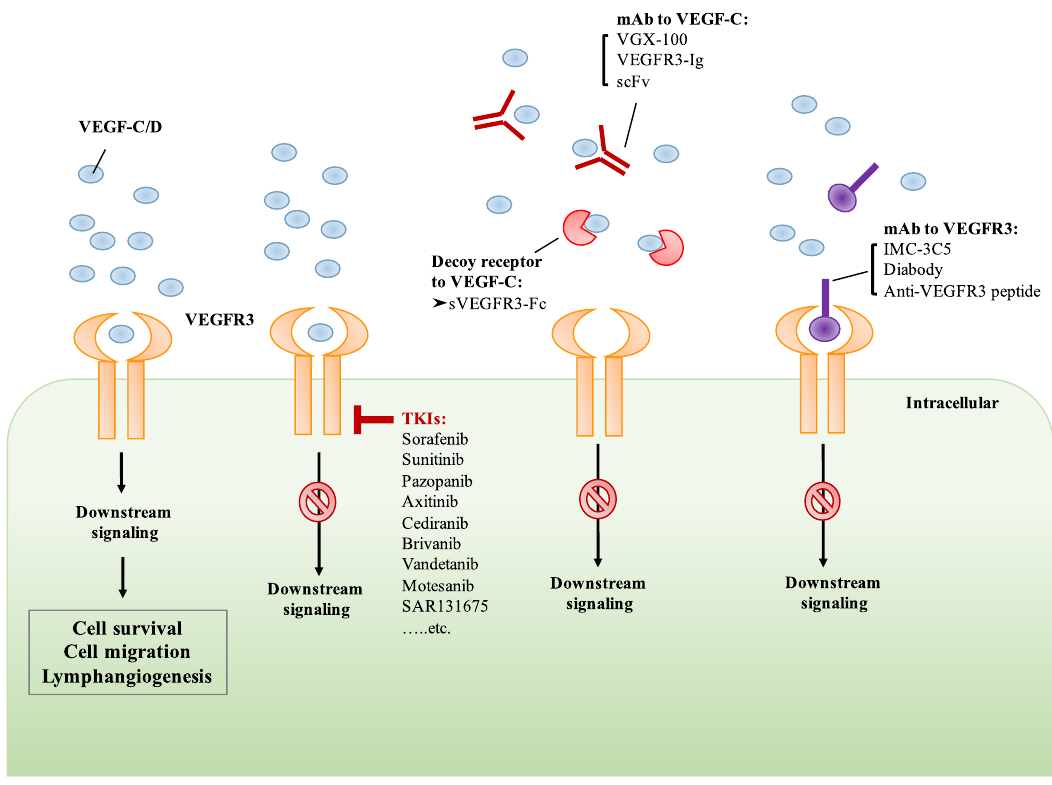
Figure 3. Targeting the VEGF-C/VEGFR3 axis by various therapeutic strategies. The binding of VEGF-C/D to VEGFR3 induces downstream signaling which mediates cell survival and lymphangiogenesis. The treatment of small molecule receptor tyrosine kinase inhibitors (TKIs) inhibits the activation of VEGF-C/D/VEGFR3 signaling. Monoclonal antibody (mAb) and receptor trap target VEGF-C, preventing its binding to VEGFR3. Monoclonal antibody or peptides targeting VEGFR3 prevent the binding of VEGF-C, resulting in the inhibition of VEGFR3 signaling.